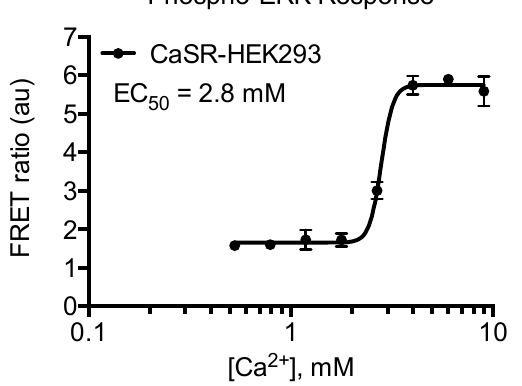
Figure 7. Characterization of calcium-induced phosphorylation of ERK1/2 in CaSR-HEK293 cells using HTRF ® based assay. Concentration-response curve of calcium in the Phospho-ERK1/2 HTRF ® assay using 5 × 10 4 cells/well (plated 24 h before) and 15 min stimulation. Increase in FRET signal is proportional to the phosphorylation of ERK1/2. Data are mean ± S.D. of triplicate determinations and representative for three independent